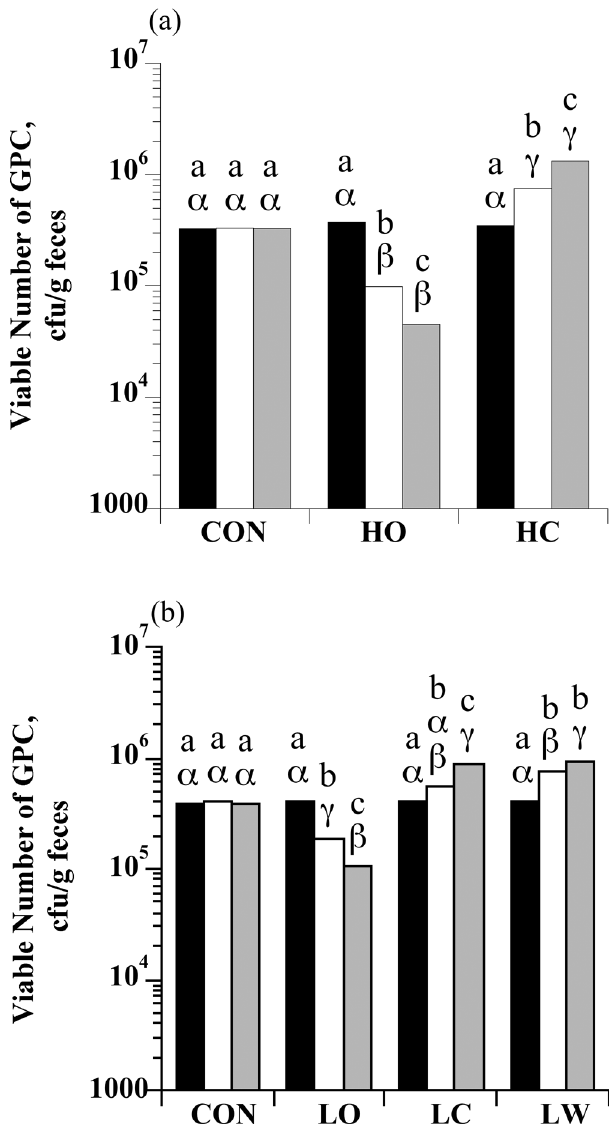
Fig 2. The effect of dietary starch source (corn, oats, and wheat middlings) on the viable number of Group D Gram-positive cocci (GPC; enterococci and Streptococcus bovis/equinus ) in equine feces. (a) Horses were assigned to treatments: hay only (CON; n = 4), high oats (HO; n = 4; 2 g starch/kg BW), or high corn (HC; n = 4; 2 g starch/kg BW). (b) Horses were assigned to treatments: hay only (CON; n = 5), low oats (LO; n = 5; 1 g starch/kg BW), low corn (LC; n = 5; 1 g starch/kg BW), or low wheat middlings (LW; n = 5; 1 g starch/kg BW). An initial sample was obtained at the end of the forage-only feeding period (S0; black bars) before starch sources were introduced. Additional samples were taken on d 6 when horses were receiving 50% of the assigned starch source (S1; open bars) and on d 13 when they were receiving 100% of the assigned starch source (S2; grey bars). Means lacking a common English letter are different within sample day point ( P < 0.05). Means lacking a common Greek letter are different between sample days within a treatment ( P < 0.05); (a) Treatment: P = 0.0026, sample day: P = 0.9259, and treatment × sample day: P < 0.0001; Pooled SEM: treatment = 0.0948, sample day = 0.0713, and treatment × sample day = 0.1234 (log 10 transformed); (b) Treatment: P = 0.0002, sample day: P = 0.0879, and treatment × sample day: P < 0.0001; Pooled SEM: treatment = 0.0642, sample day = 0.0423, and treatment × sample day = 0.0859 (log 10 transformed).